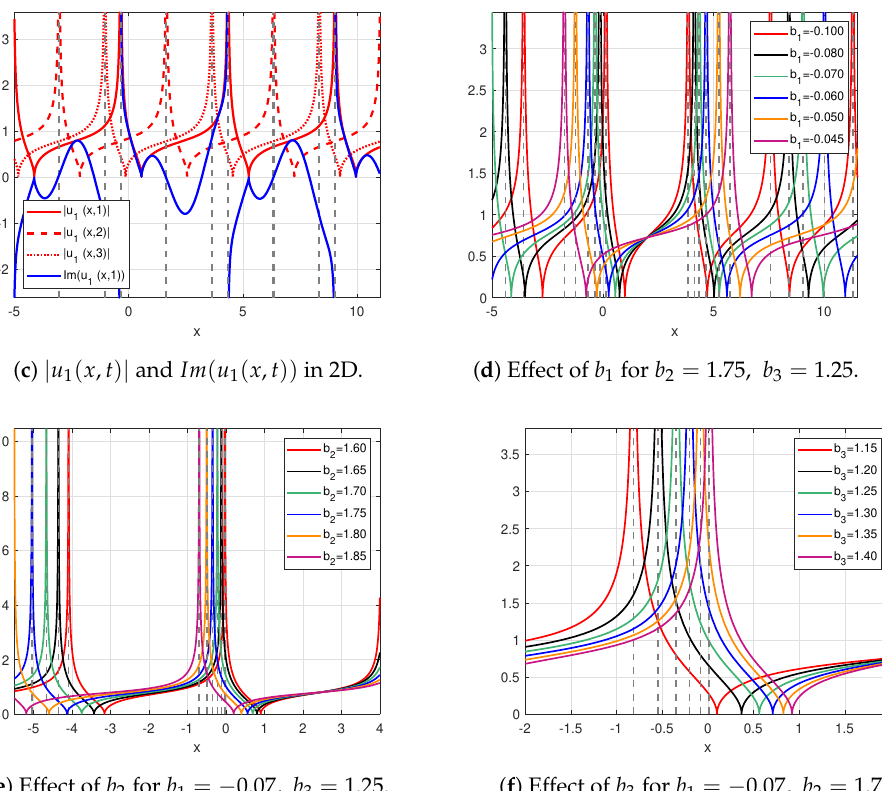
Figure 3. The various depictions of u 1 ( x , t ) in Equation (19) by combination of the Set 3 in Equation (14) and the selected h = − 0.04, a = − 0.5, φ 0 = 0.5, b 1 = − 0.07, b 2 = 1.75, b 3 = 1.25, κ = 2 values. Figure 4 projects the different soliton behavior of the investigated equation. It is a depiction of u 4 ( x , t ) in Equation (22) with the selected Set 4 in Equation (15) by assuming the parameter values as h = − 0.04, a = − 0.5, φ 0 = 0.5, b 1 = − 0.7, b 2 = 0.5, b 3 = 0.25, κ =